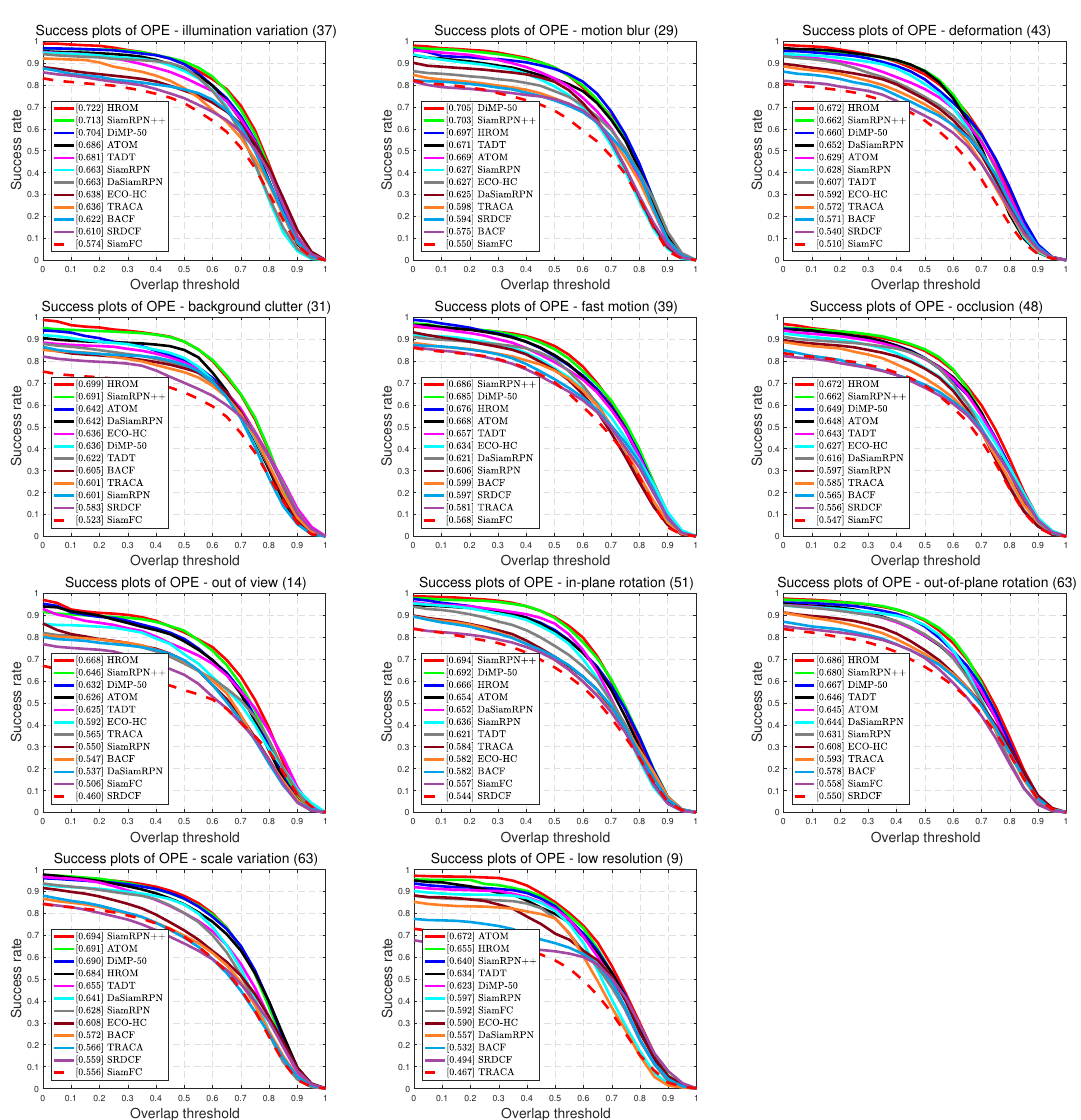
Figure 7. Success plots of different trackers with 11 attributes on the OTB-2015